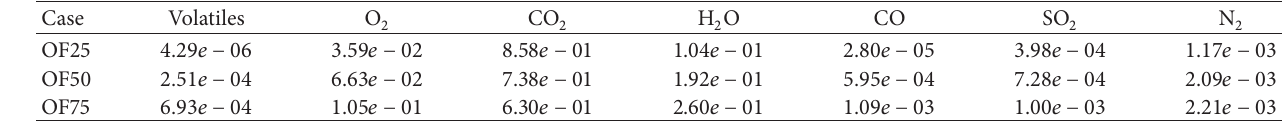
Table 3: Outlet gas composition (mole fraction).